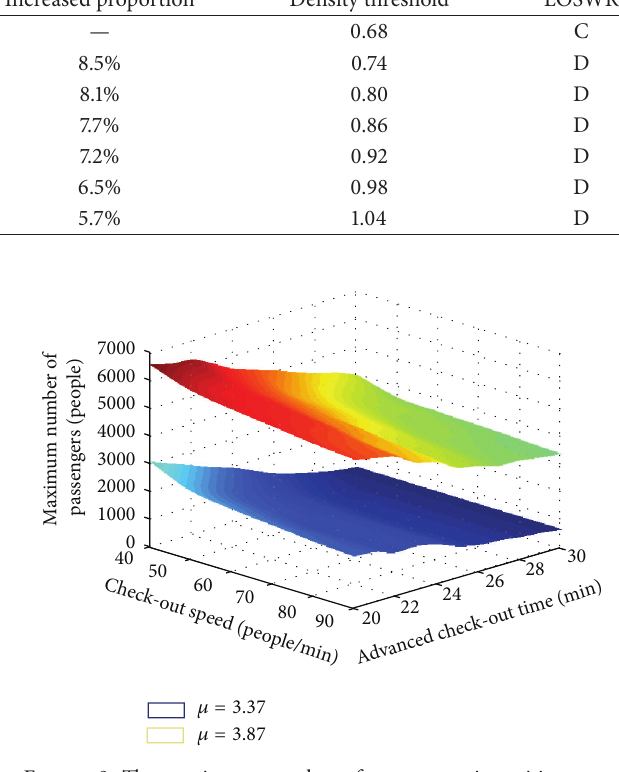
Figure 9: The maximum number of passengers in waiting room varies over the values of 𝑡 𝑐 and V 𝑐